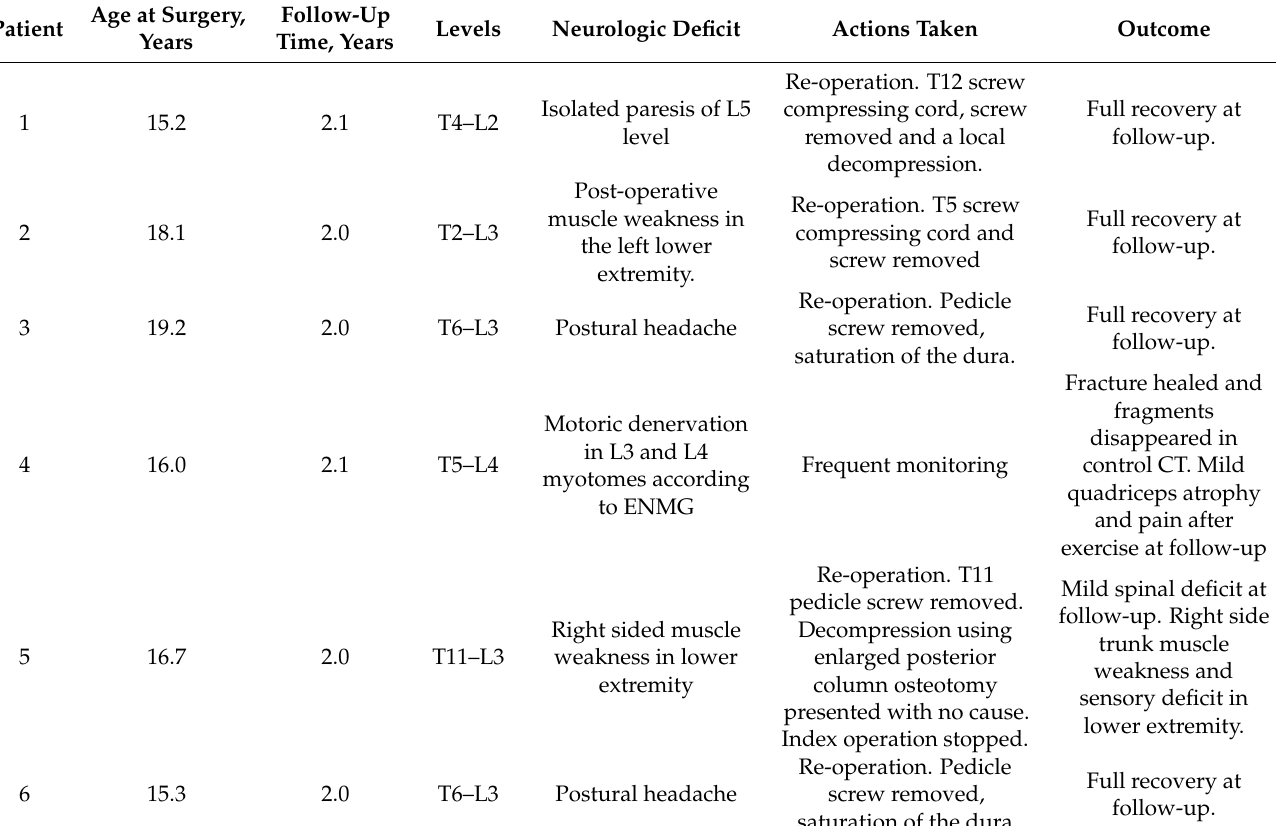
Table 3. New postoperative neurologic deficits and